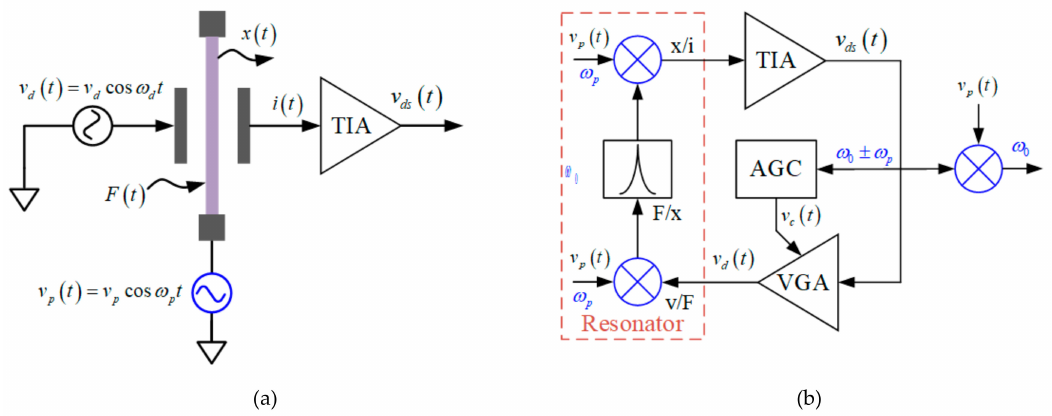
Figure 4. Schematics of MEMS resonator adopting AC polarization in ( a ) open-loop driving and ( b ) closed oscillation